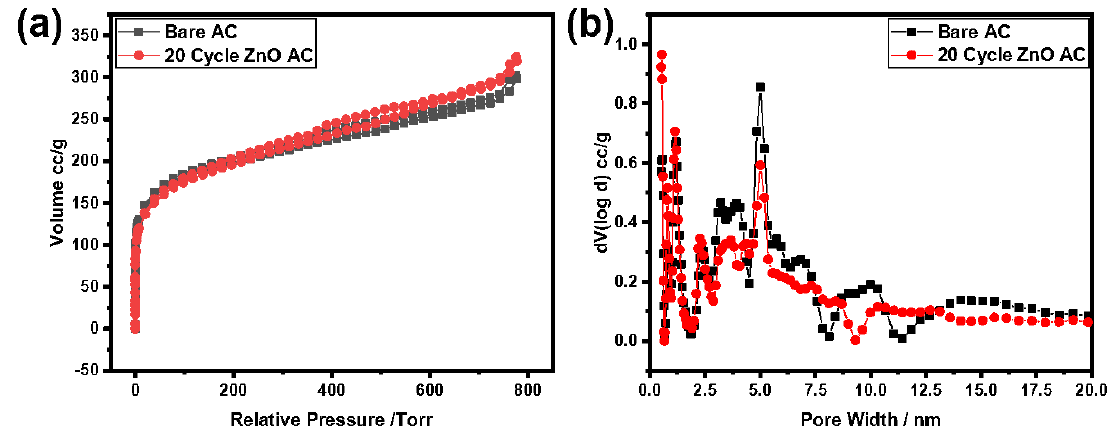
Figure 8. ( a ) Nitrogen adsorption and desorption isotherms; ( b ) pore size distribution for bare AC and 20-cycle ZnO at 100 ms and 70 C.